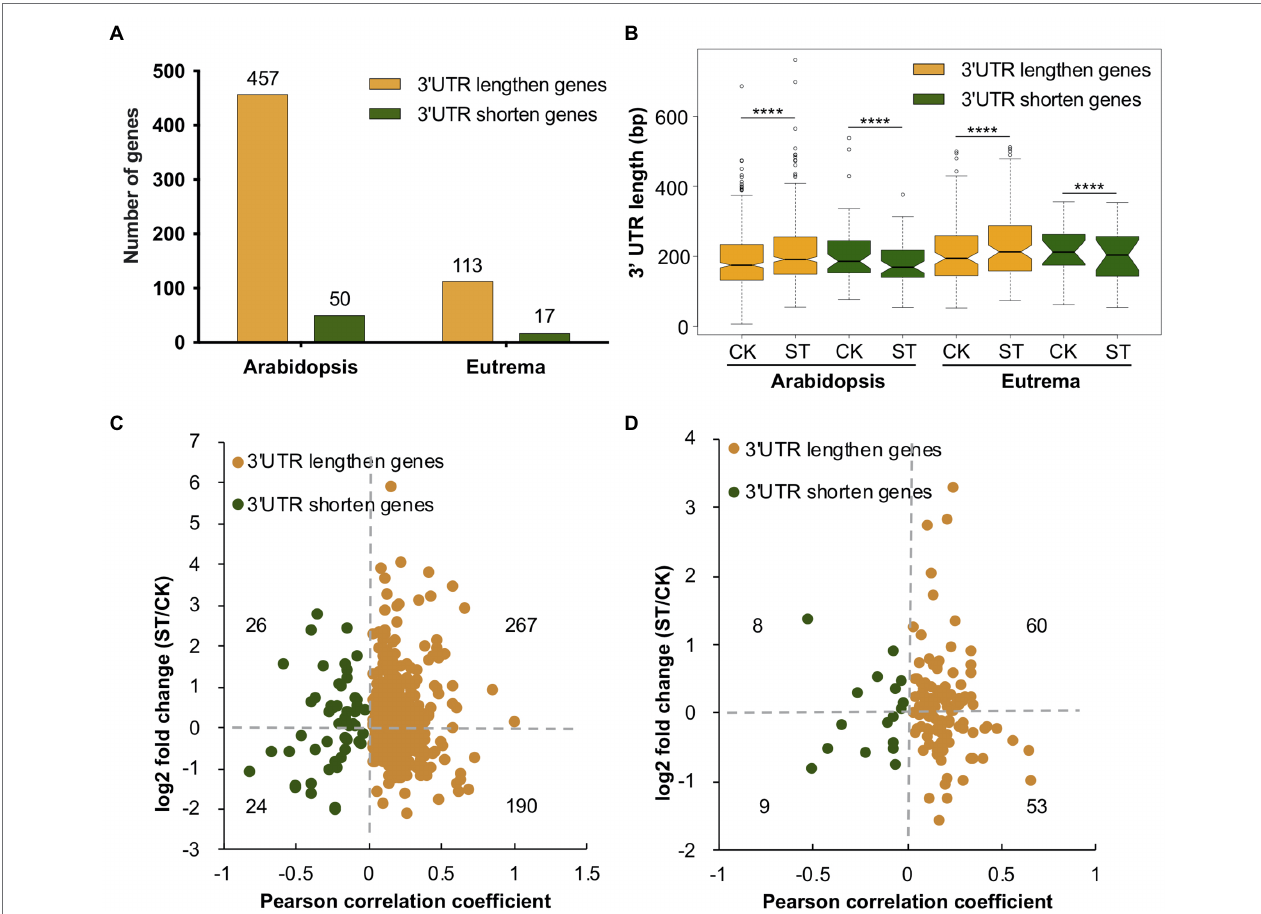
FIGURE 5 | 3 ′ UTR length analysis in Arabidopsis and Eutrema . (A) The number of genes showing changes in the length of 3 ′ UTR under salt stress. (B) 3 ′ UTR length of 3 ′ UTR changing genes under control (CK) and salt stress (ST) conditions. Statistical significance was determined by the Wilcoxon matched-pairs signed rank test, **** p < 10e − 04. (C,D) Relationships between 3 ′ UTR length and gene expression level in Arabidopsis and Eutrema , respectively. Numbers indicate the number of genes. The X -axis indicates the strength of the change in the length of 3 ′ UTR; Pearson correlation coefficient > 0 indicates a longer 3 ′ UTR, Pearson correlation coefficient < 0 indicates a shorter 3 ′ UTR. The Y -axis indicates gene expression level; log2 fold change > 0 indicates upregulation, log2 fold change < 0 indicates